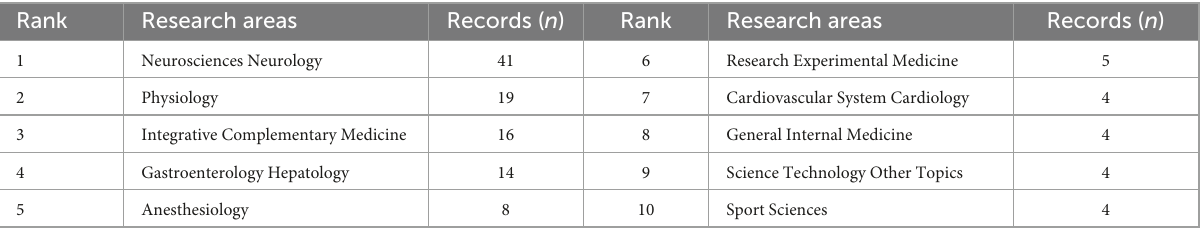
TABLE 5 Top 10 well-represented research